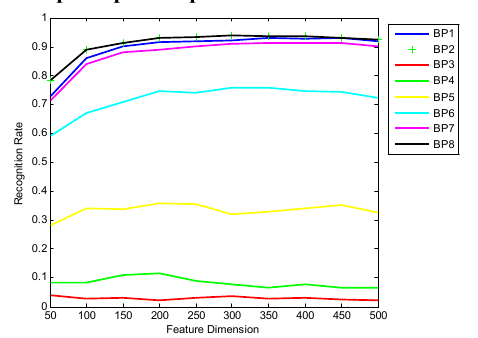
Fig.4 Variation in recognition rate of each bit-plane with the number of principal components retained on AR